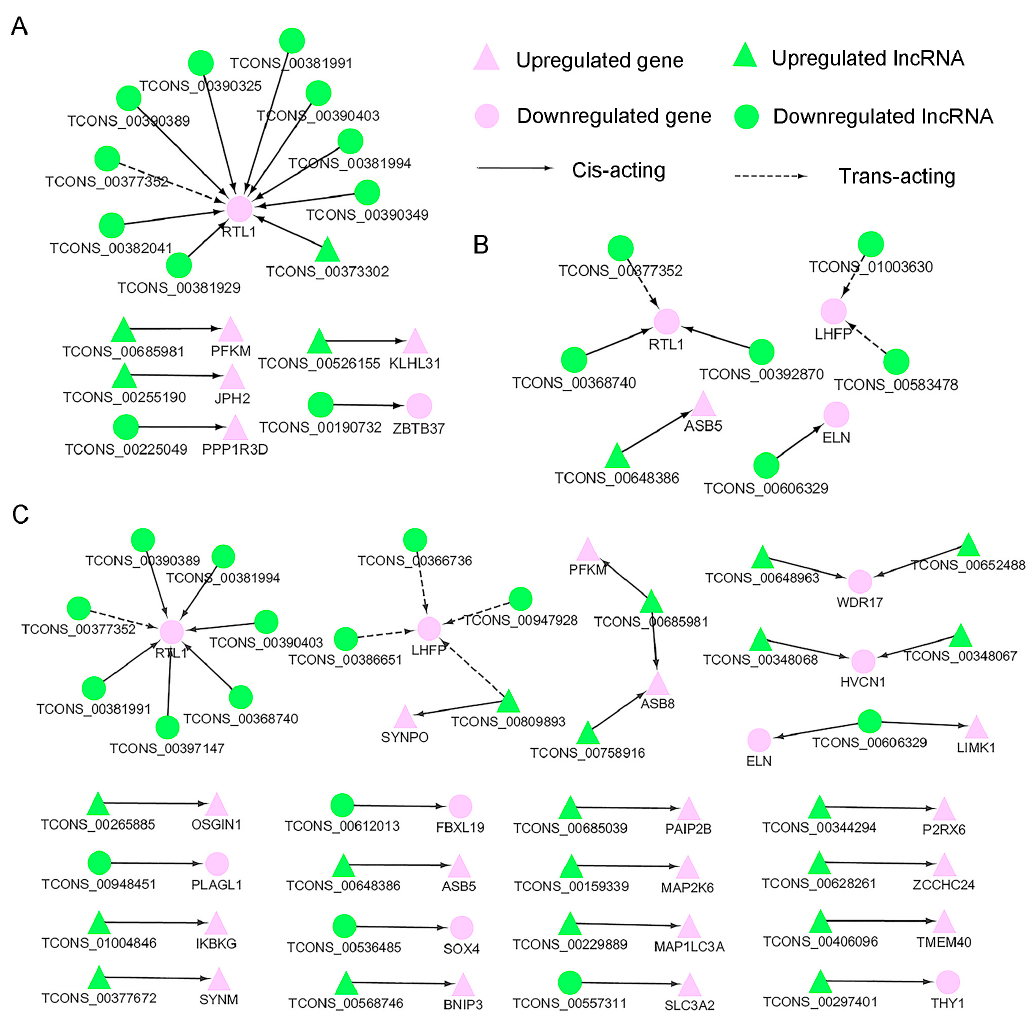
Figure 8. LncRNA–gene networks for (control/experiment) fetus/lamb, lamb/adult and fetus/adult comparisons. ( A ) LncRNA–gene network for the comparison of fetus/lamb. ( B ) LncRNA–gene network for the comparison of lamb/adult. ( C ) LncRNA–gene network for the comparison of fetus/adult. Differentially expressed lncRNAs and their corresponding differentially expressed cis- and trans-acting target genes were used to construct the lncRNA–gene interaction network. In this network, genes are displayed in purple while lncRNAs are displayed in green; upregulation is indicated with triangles while downregulation is indicated with circles. The cis-acting interactions are represented as solid lines, whereas the trans-acting interactions are represented as dashed lines. RTL1, retrotransposon-like 1; JPH2, junctophilin-2; ELN, elastin; LIMK1, LIM domain kinase 1; PFKM, phosphofructokinase, muscle; ASB8, ankyrin repeat and SOCS box containing 8; USP2, ubiquitin specific peptidase 2; ASB5, ankyrin repeat and SOCS box containing 5; WDR17, WD repeat domain 17; LHFP, lipoma HMGIC fusion partner; HVCN1, hydrogen voltage gated channel 1; KLHL31, kelch like family member 31; ZBTB37, zinc finger and BTB domain containing 37; PPP1R3D, protein phosphatase 1 regulatory subunit 3D; SYNPO, synaptopodin; OSGIN1, oxidative stress induced growth inhibitor 1; PLAGL1, PLAG1 like zinc finger 1; IKBKG, inhibitor of nuclear factor kappa B kinase subunit gamma; SYNM, synemin; FBXL19, F-box and leucine rich repeat protein 19; SOX4, SRY-box 4; BNIP3, BCL2 interacting protein 3; PAIP2B, poly(A) binding protein interacting protein 2B; MAP2K6, mitogen-activated protein kinase kinase 6; MAP1LC3A, microtubule associated protein 1 light chain 3 alpha; SLC3A2, solute carrier family 3 member 2; P2RX6, purinergic receptor P2X 6; ZCCHC24, zinc finger CCHC-type containing 24; TMEM40, transmembrane protein 40; THY1, Thy-1 cell surface